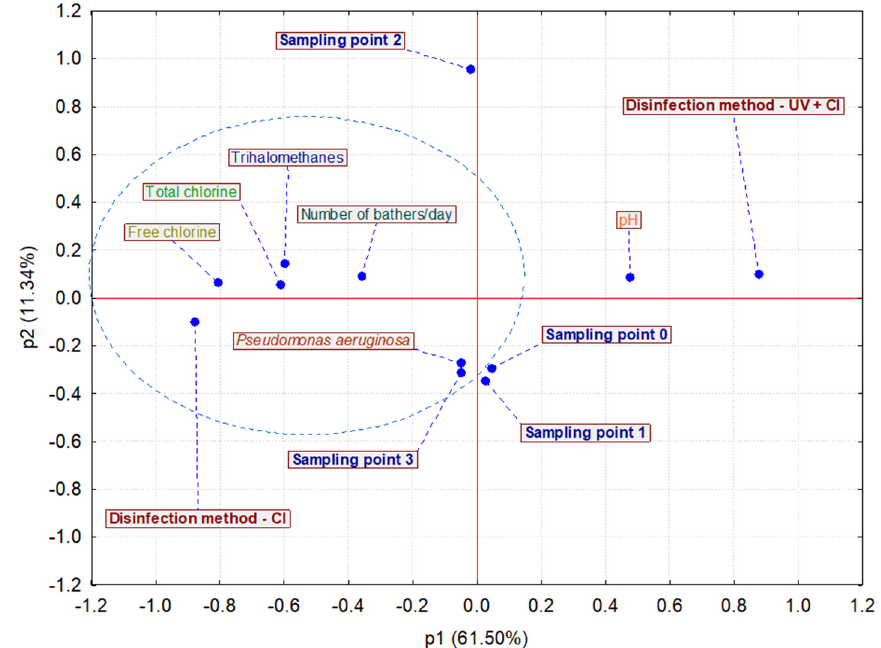
Figure 2. Selected chemical parameters, the number of bathers per day, and Pseudomonas aeruginosa bacteria levels of analyzed pool waters with the disinfection methods of chlorination (Cl) and chlorination with UV radiation (UV + Cl), represented by principal component analysis (PCA) (N = 864; 216 samples × four sampling points).